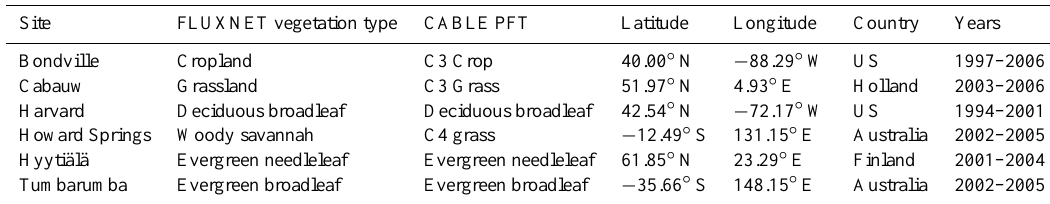
considering the impacts of temperature and aridity. Table 4. Summary of flux tower